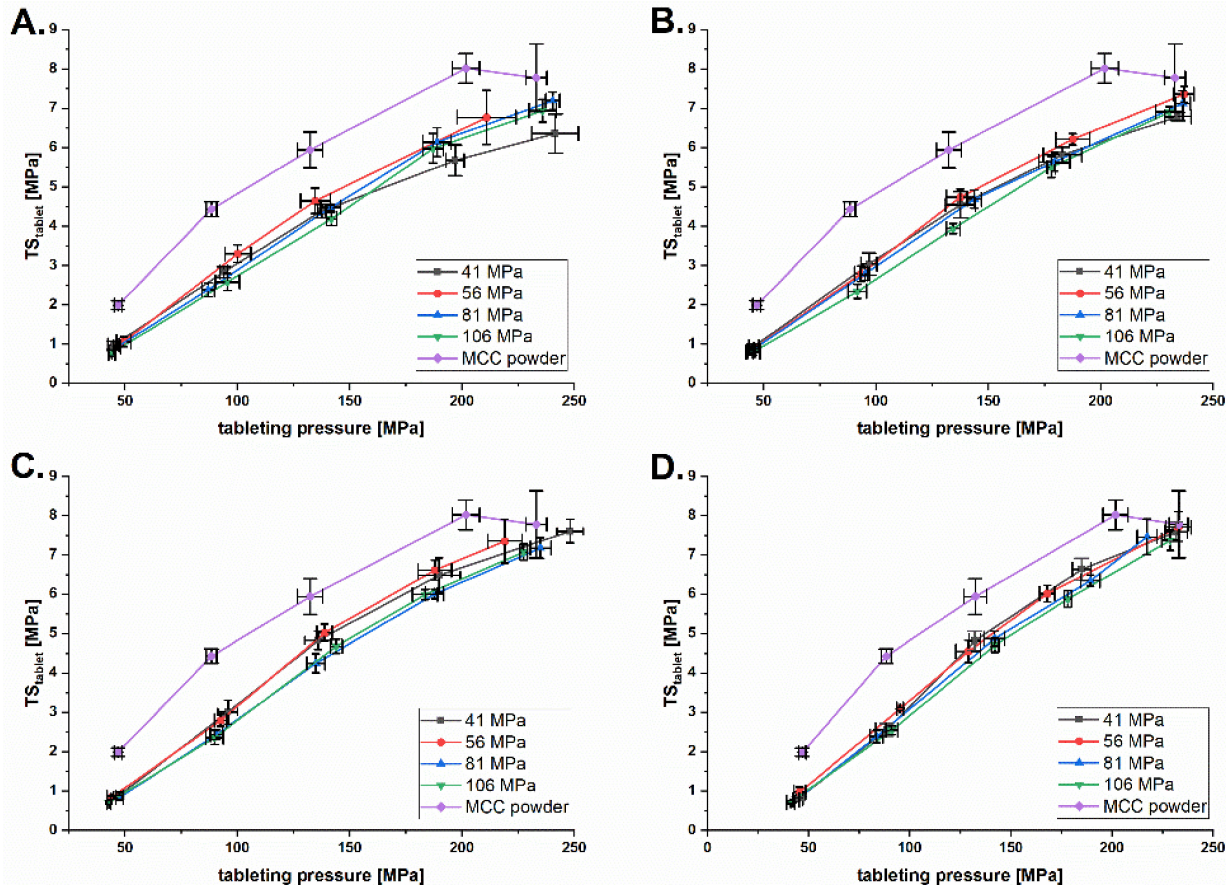
Figure 12. Tabletability plot of MCC granules at DTs of 200 ms ( A ), 133 ms ( B ), 67 ms ( C ) and 20 ms ( D ) and P max of 41–106